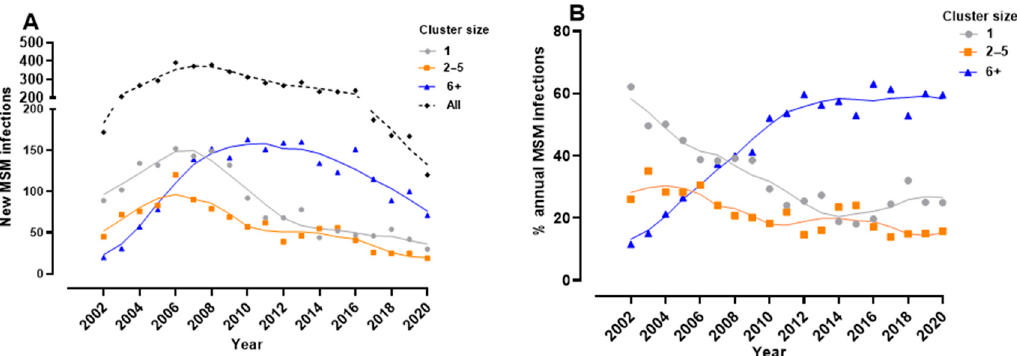
Figure 2. Phylogenetic resolution of patterns of spread of the subtype B epidemic amongst MSM. ( A ) The annual number of newly genotyped, treatment-naïve MSM segregating as singleton (grey), small-clustered networks (2-5, orange), or large-clustered cluster networks (6+ members, blue). Cluster group sizes of newly genotyped persons were assigned based on cumulative cases at end of each year; ( B ) The proportionate contribution of singleton transmissions (grey), small (orange), and large cluster (blue) networks in the annual growth of the subtype B HIV epidemic in the MSM